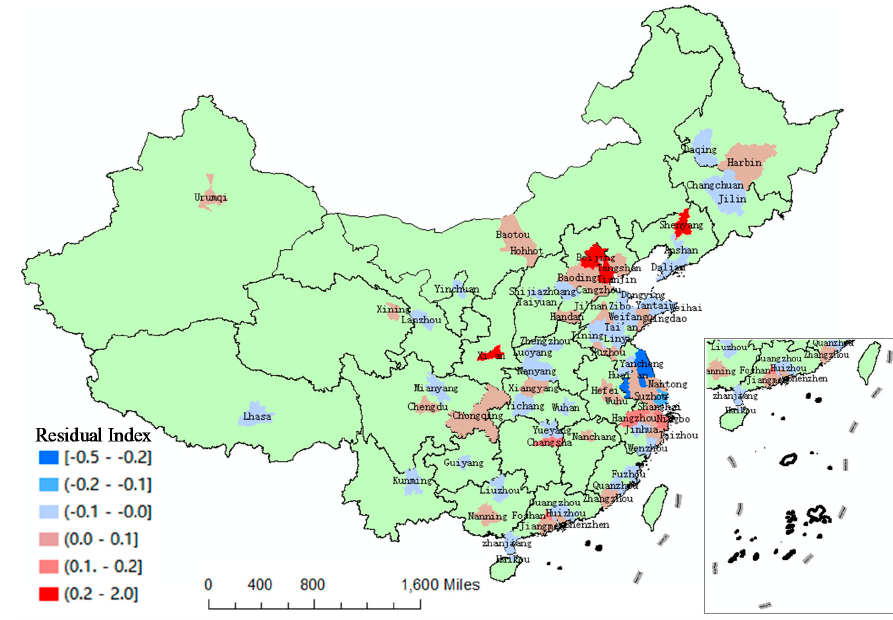
Figure 13. Distribution of 85 Chinese cities’ absolute residuals using OSM road network density and